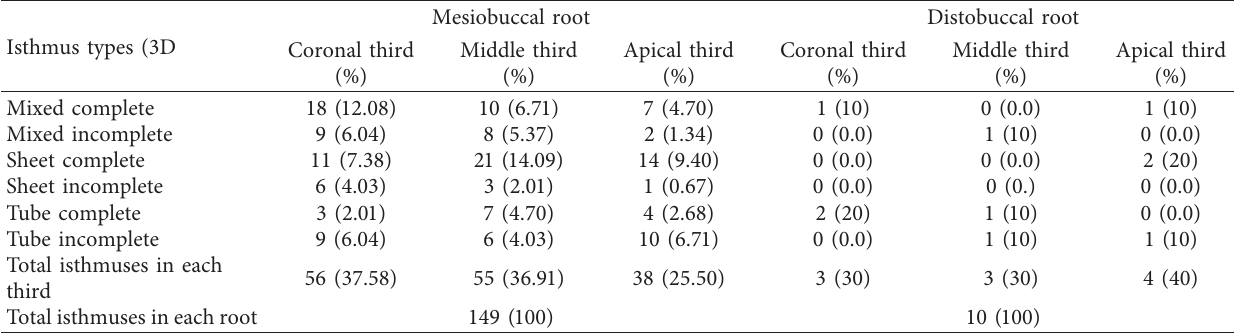
Table 7: Incidence of 3D isthmus types at different levels of mesiobuccal and distobuccal